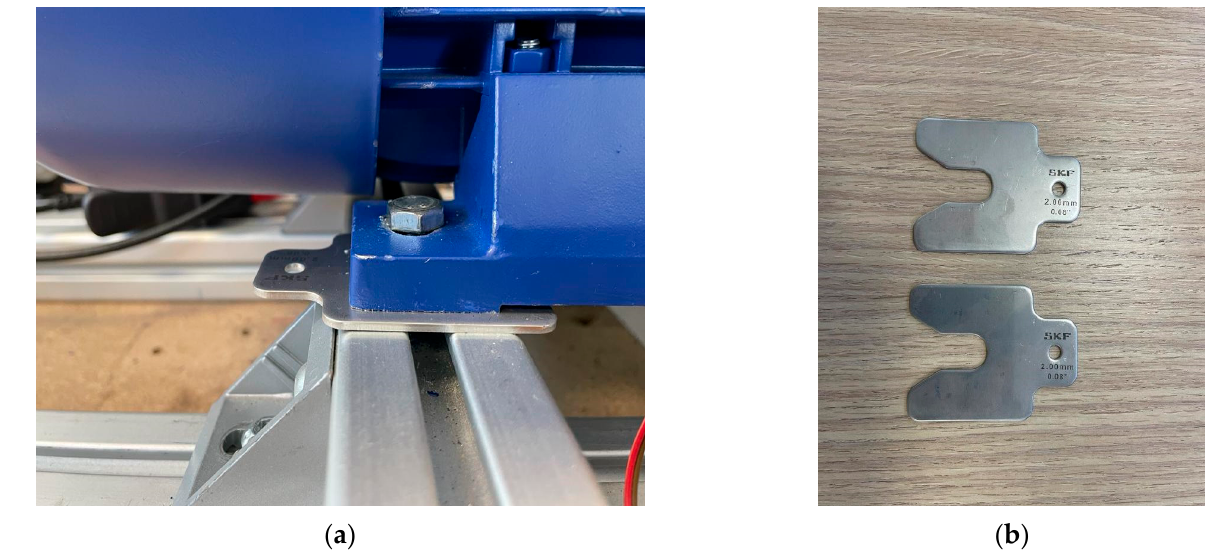
Figure 7. ( a ) Shim on the back SynRM mounting, ( b ) 2 mm shims used to force misalignment in the SynRM.